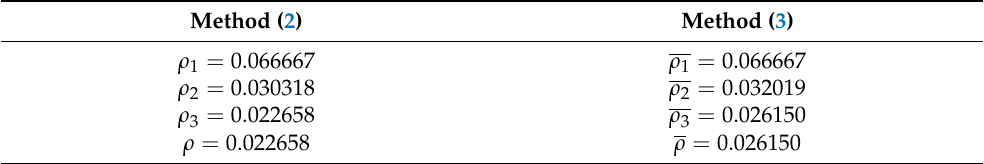
Table 2. Comparison of convergence radii for Example 2.